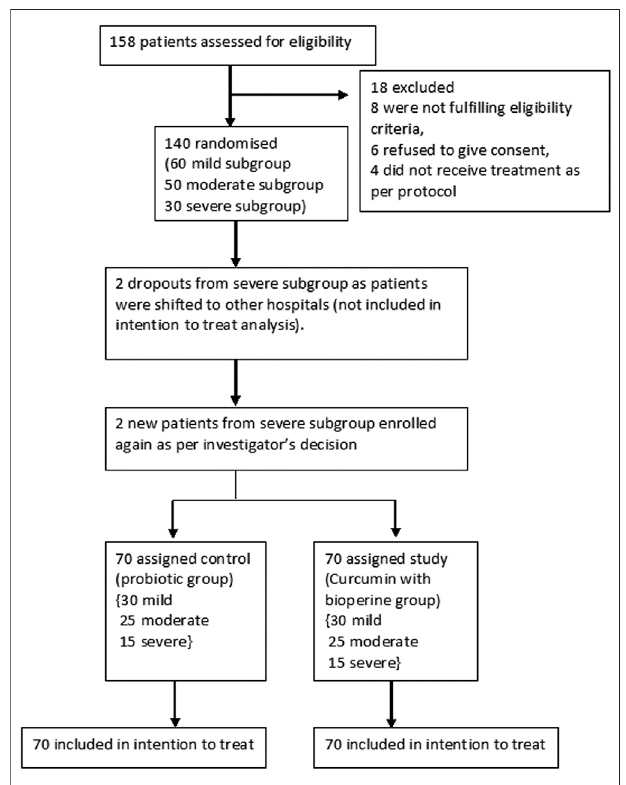
FIGURE 1 | CONSORT fl ow diagram for this